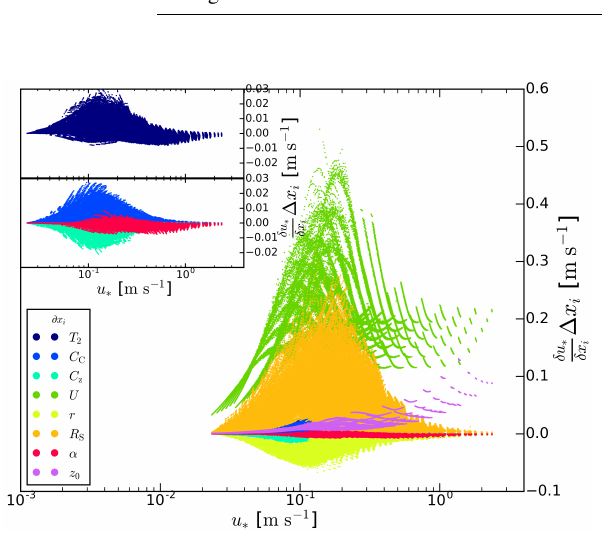
Figure 3. Sensitivity of friction velocity ( u ∗ ) with respect to in- put variables of MPP-FMI. The main figure shows sensitivities of the most important input variables, whereas the inserts show the less sensitive input variables. The partial derivatives have been nor- malised by the range of the input parameters ( (cid:49)x i ) described in Table 2 in order to make them